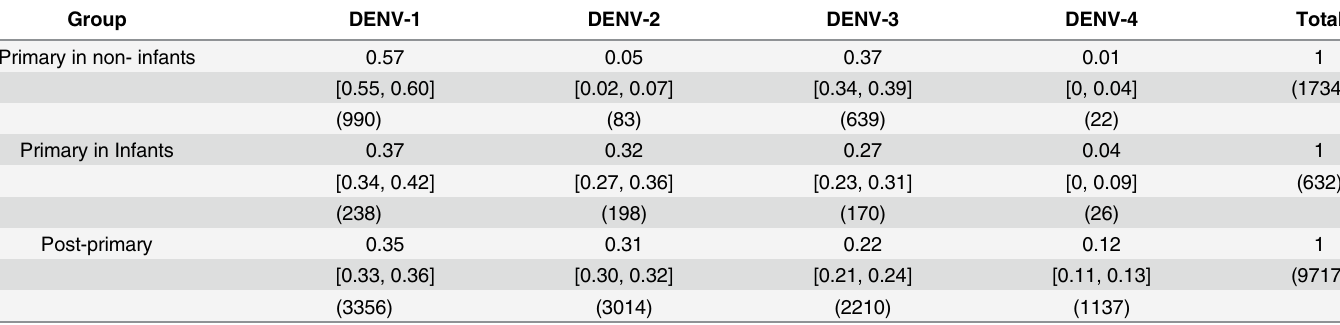
Table shows proportion and 95% multinomial con fi dence intervals in square brackets. Case numbers are in parentheses. The accompanying fi gure, with the data by year, is Fig 1.